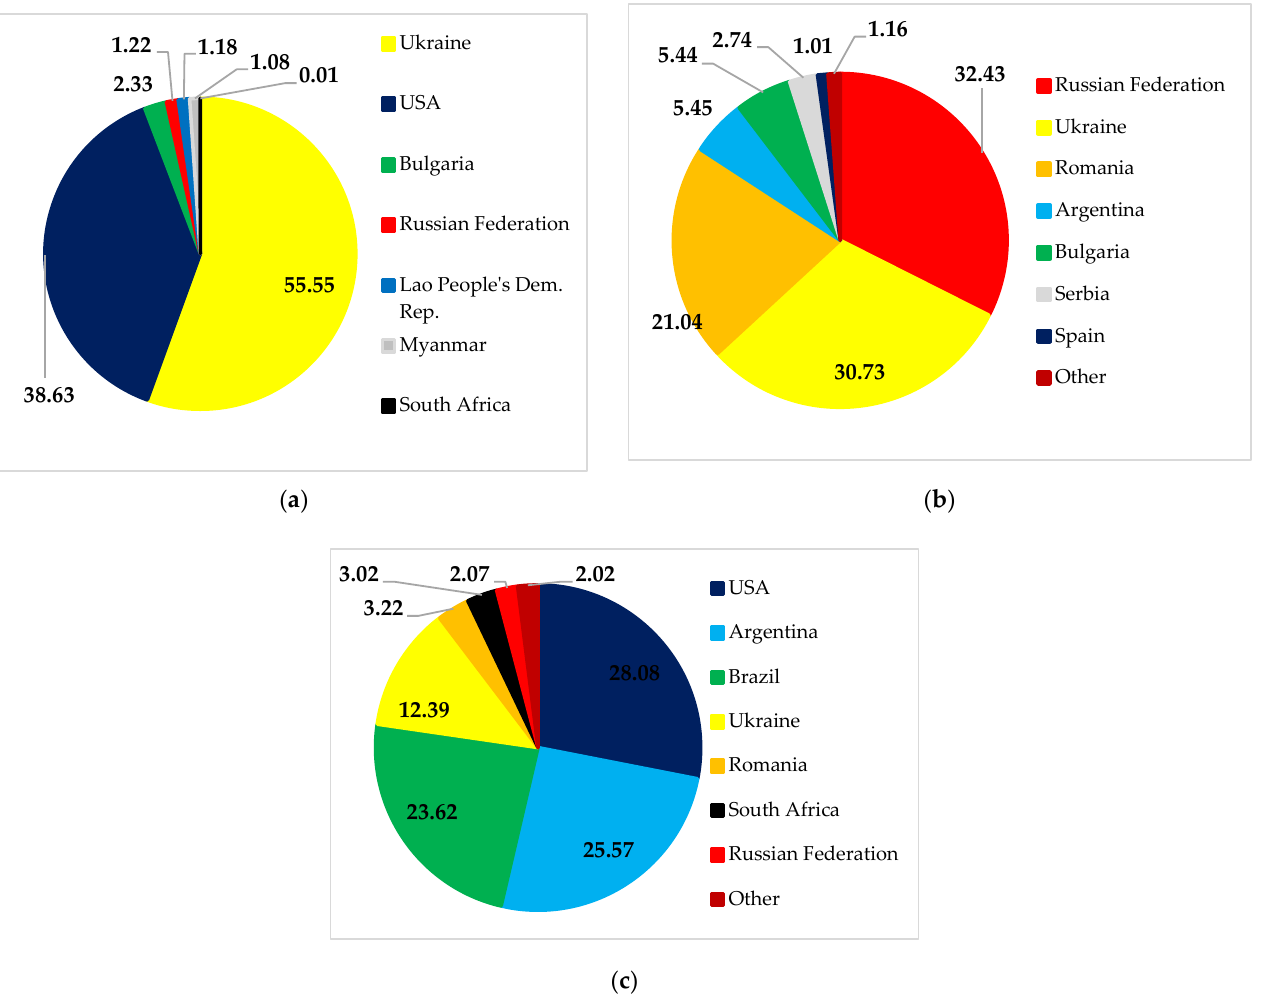
Figure 14. China’s ( a ), Turkey’s ( b ), and Korea’s ( c ) maize import structure. Source: [30]. The war has generally decreased Ukrainian exports of wheat and maize (Table 4).